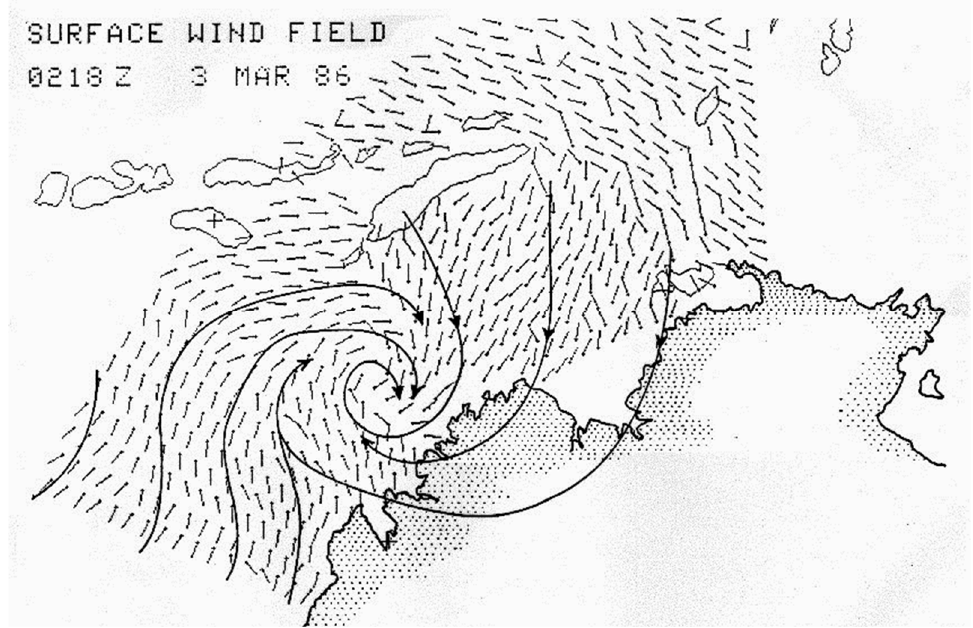
Figure 20. A low-resolution map of the wind direction recorded from Tropical Cyclone Victor in March 1986 [76].